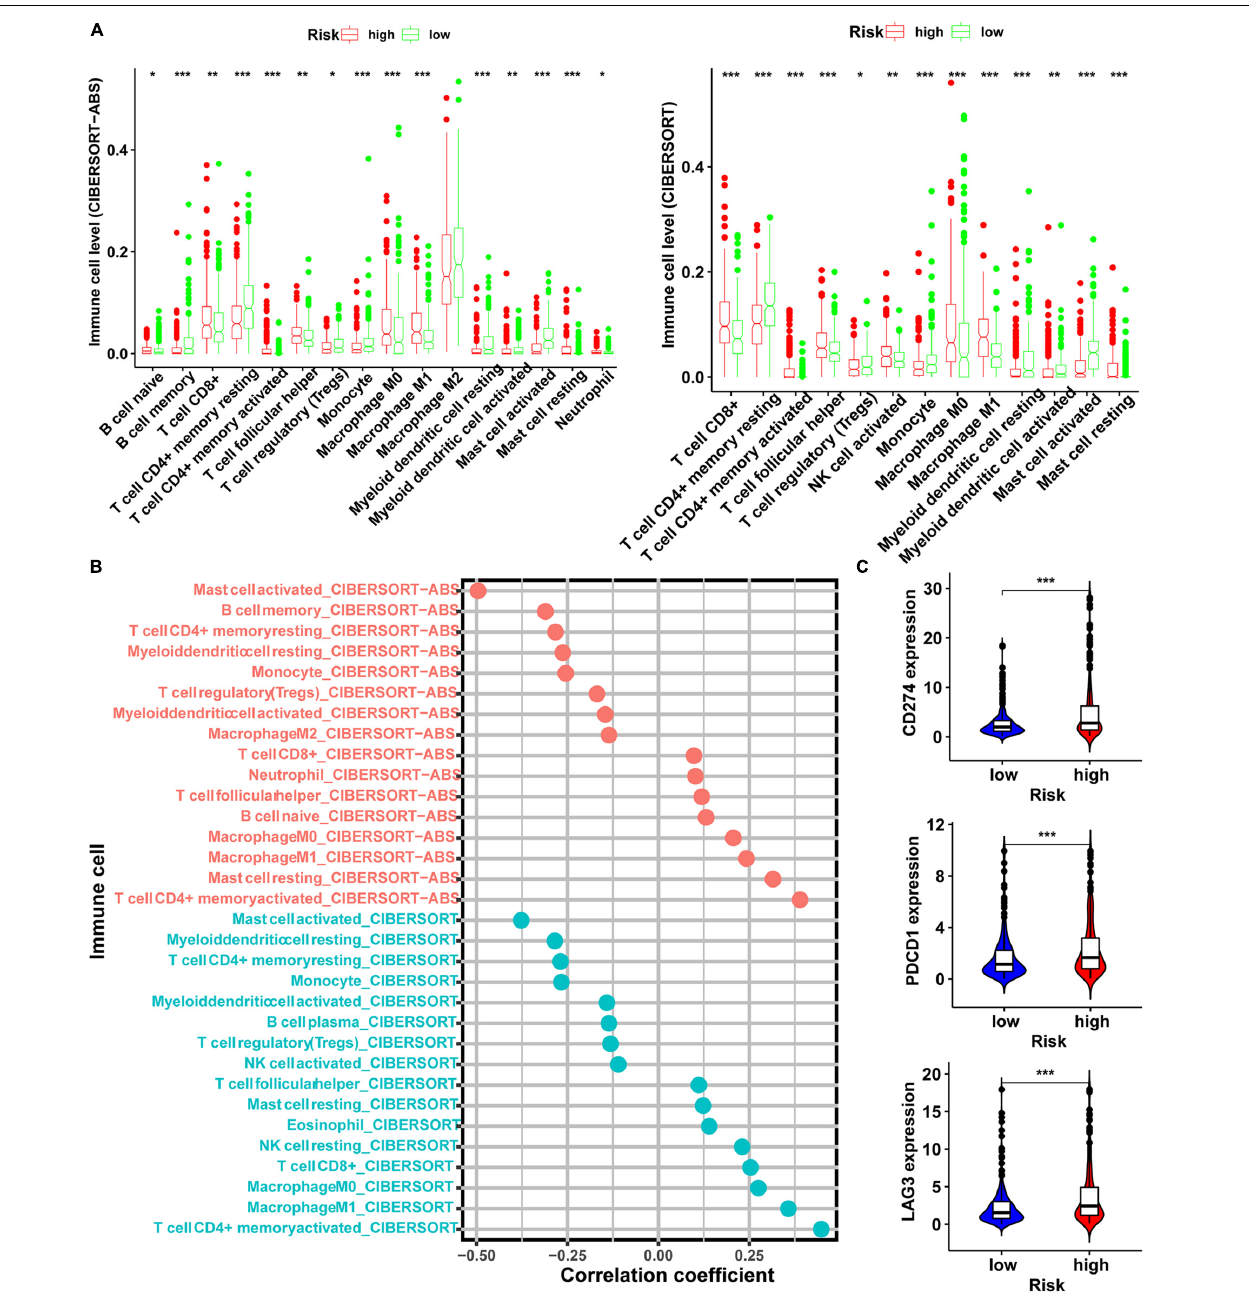
FIGURE 6 | Exploration of the relationship between risk score and level of immune cells and immunosuppressive genes. (A) The level of immune cells in tumor evaluated by CIBERSORT-ABS and CIBERSORT software in the high- and low-risk groups. (B) Spearman correlation analysis of risk score and level of immune cells evaluated in CIBERSORT-ABS and CIBERSORT software. (C) The expression level of immunosuppressive genes in the high- and low-risk groups (* p < 0.05; ** p < 0.01; *** p < 0.001).